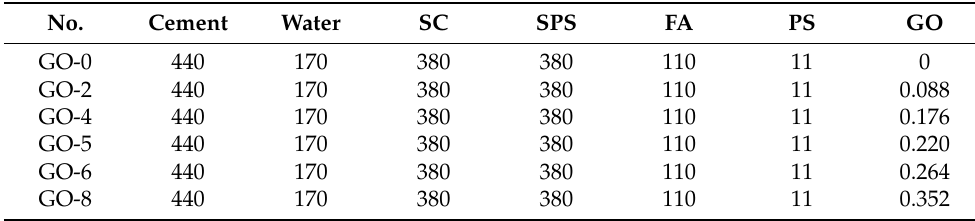
Table 3. Mix proportion (kg/m 3